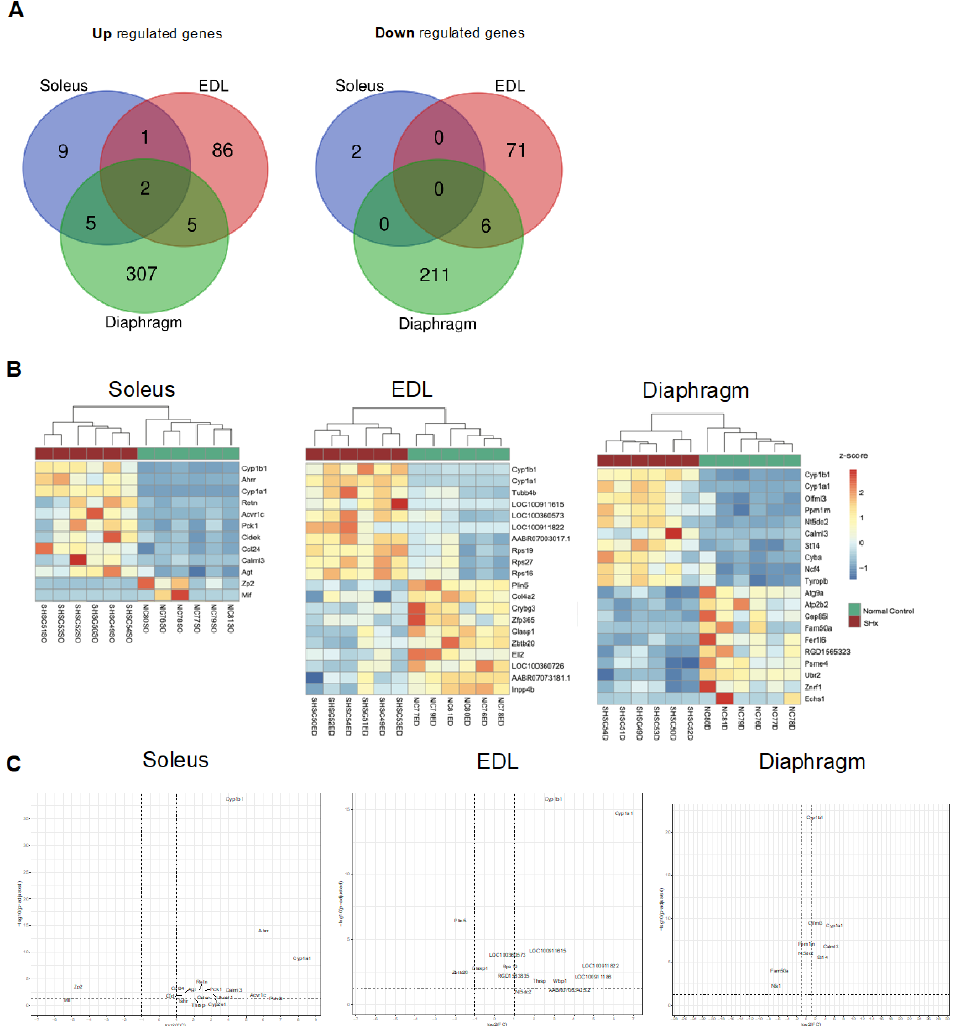
Figure 7. ( A ) Venn diagram showing the number of differentially expressed genes (DEGs) in the SU/Hx vs. control groups in three tissues: soleus, EDL, and diaphragm. ( B ) Hierarchical clustering analysis of the top 10 most significantly upregulated genes for soleus, EDL, and diaphragm, the two most significantly downregulated differential expressed genes that were identified in soleus, and the 10 most downregulated differential expressed genes in EDL and diaphragm between SU/Hx and control groups. ( C ) Volcano plot of the mRNA transcripts of soleus, EDL, and diaphragm in the SU/Hx vs. control groups. Significantly downregulated genes are in red, significantly upregulated genes are in green, nonsignificant genes are in gray. n = 6 individual animals per group.